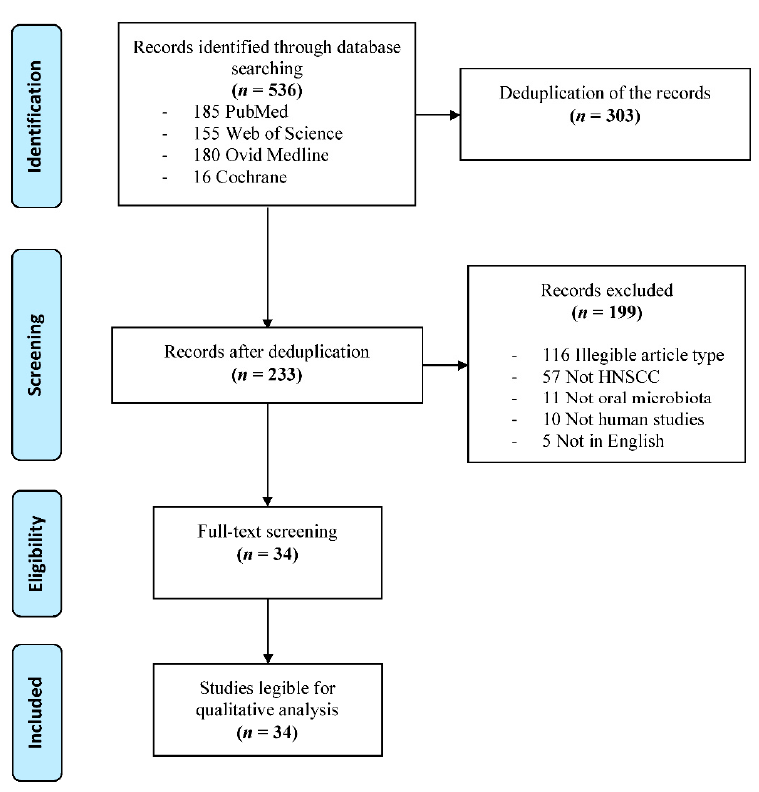
Figure 1. PRISMA flowchart of the study selection process.